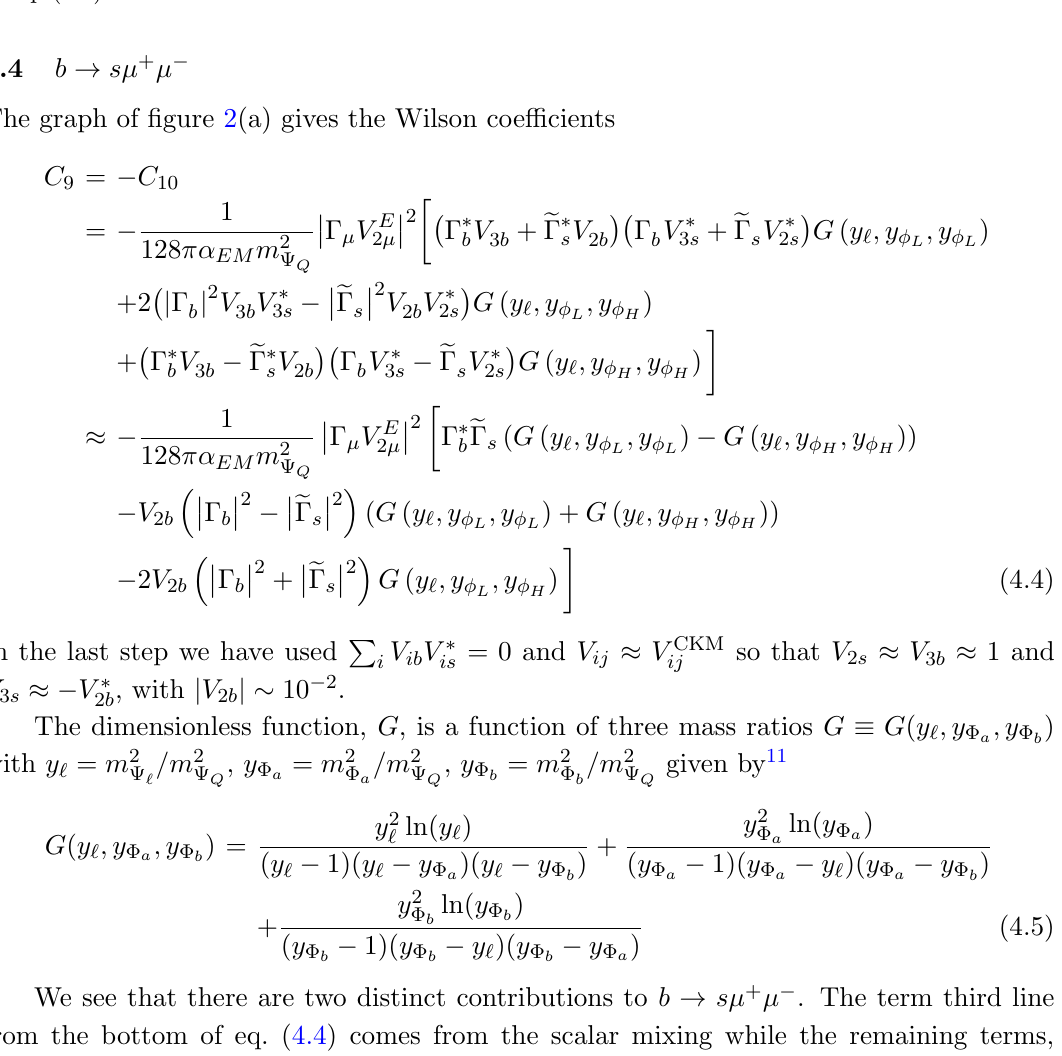
Figure 2 . Box-diagrams contributing to (a) b ! s(cid:22) + (cid:22) (cid:0) and (b) B s ! (cid:22) B s , with couplings given in eq.